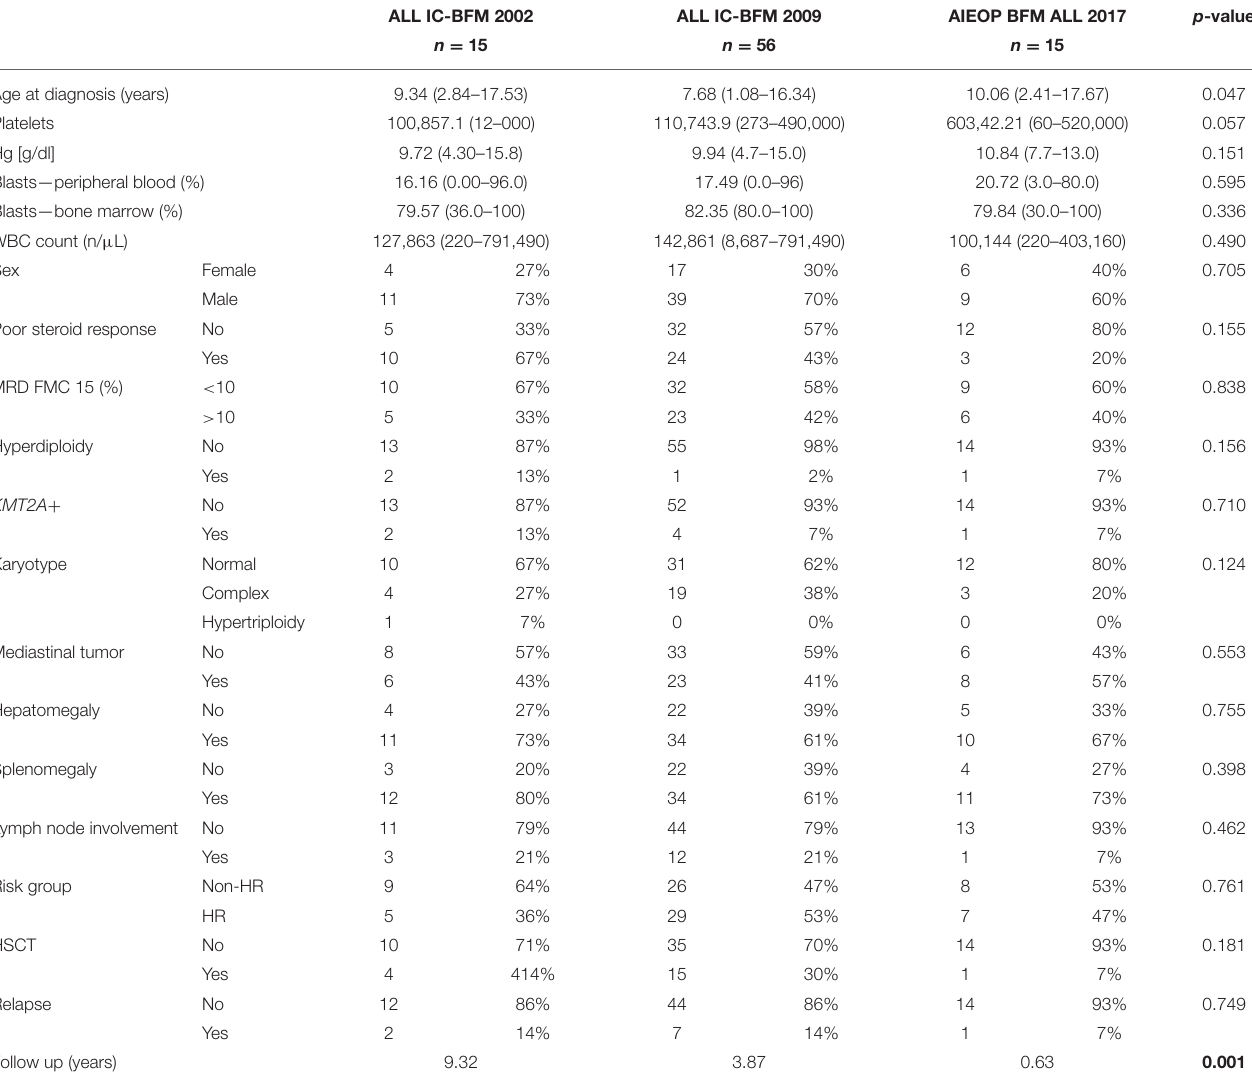
TABLE 1 | Clinical and biological characteristics of the study group with respect to the implemented treatment